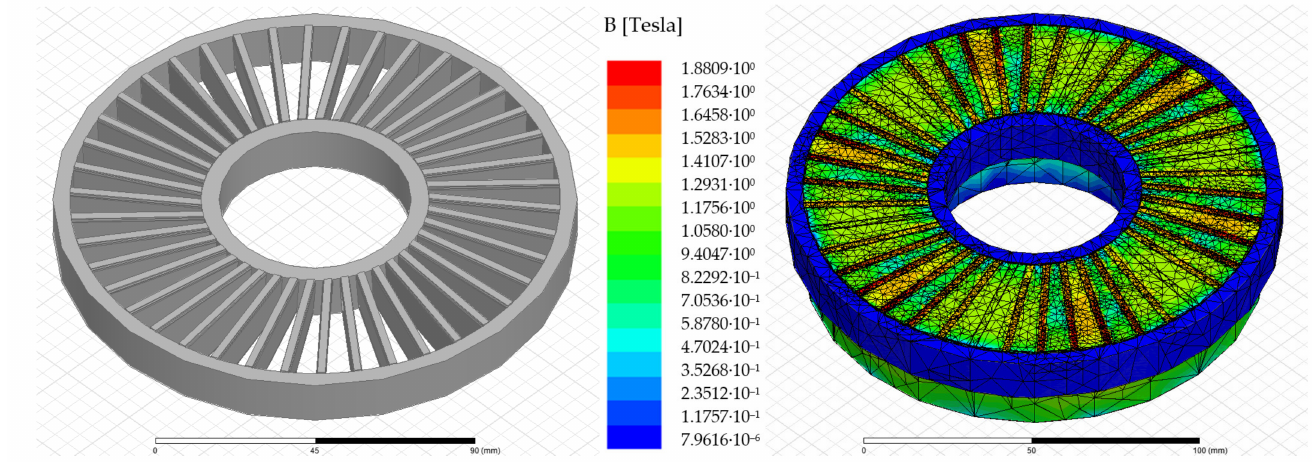
Figure 8. The 3D geometry of a squirrel cage with tilted bars ( left ); the distribution of the magnetic flux density in the symmetrical half of the inner rotor, visualized with advanced meshing with local refinements in the area of the rotor slots and squirrel cage bars ( right ).